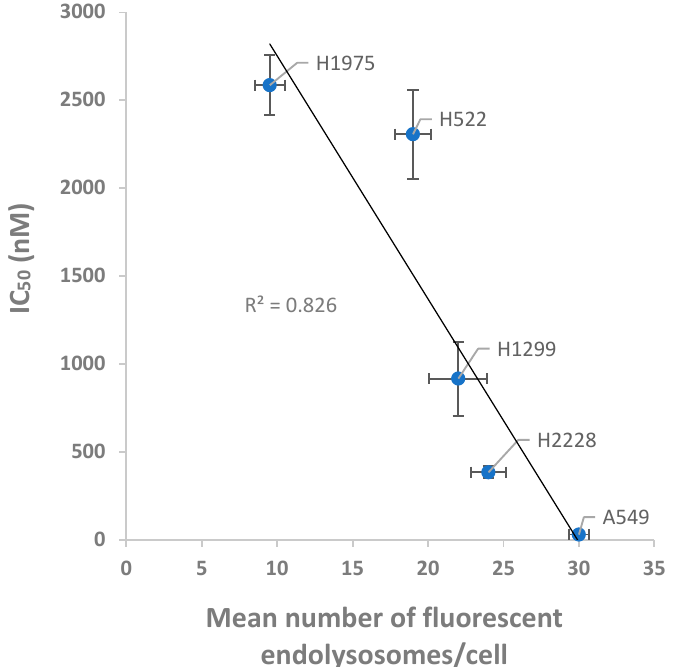
Figure 8. Correlation between the cytotoxic effect to various target NSCLC cells and the internalization ability of PTX-loaded APT-NPs. The IC 50 value (30 nM) of A549 cells exposed to the same drug delivery system, was determined in our previous study, Engelberg et al. [38].